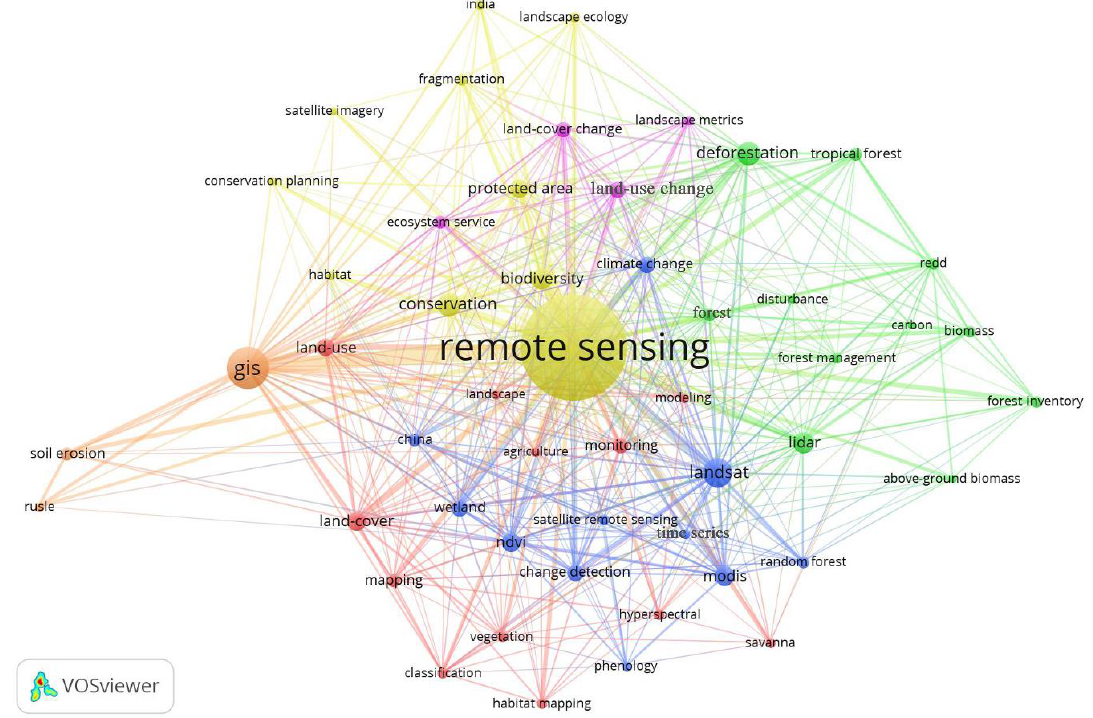
Figure 7. Keywords co-occurrence network. Each node represents a keyword, the size of the node indicates the number of occurrences of the keyword, and the line thickness of the two nodes represents the degree of connection.